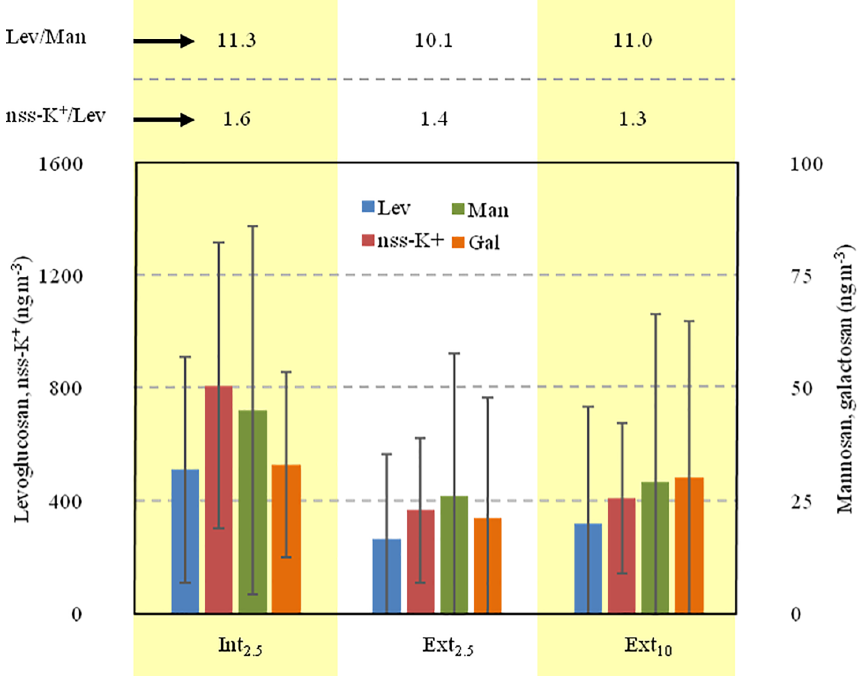
Figure 6. Concentrations of biomass burning tracers for all